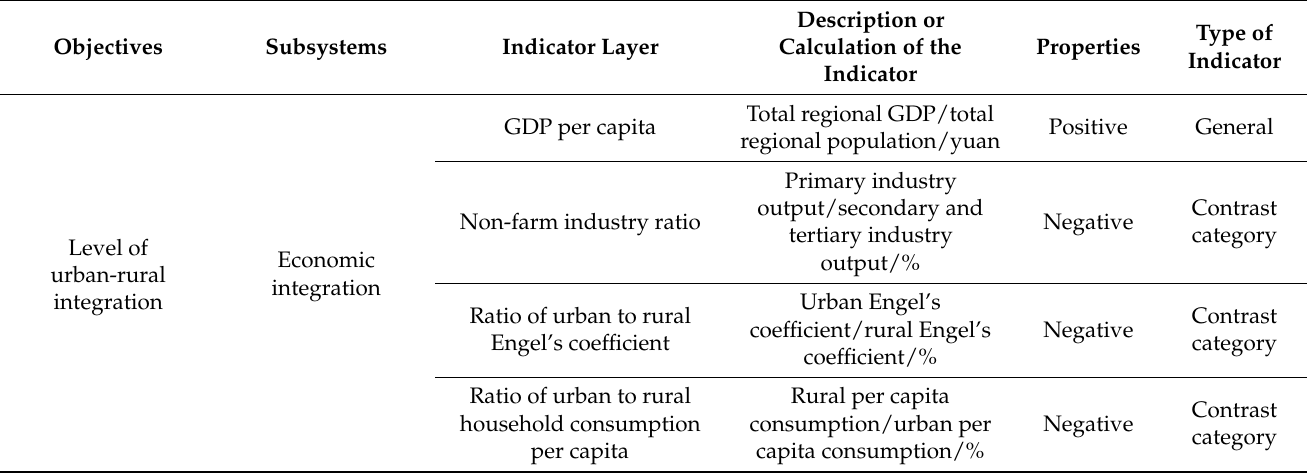
Table 1. Urban-rural integration evaluation indicator